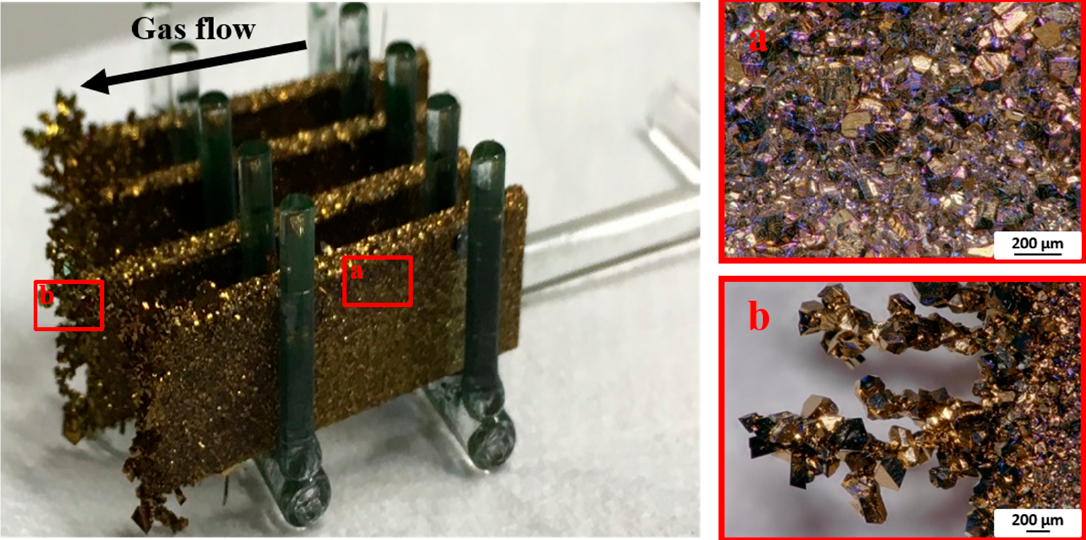
Figure 2. Appearance of corrosion products on N10276 after corrosion experiments with ( a ) and ( b ) magnified view. XRD measurements were performed on a PanAlytical X’Pert Pro diffractometer